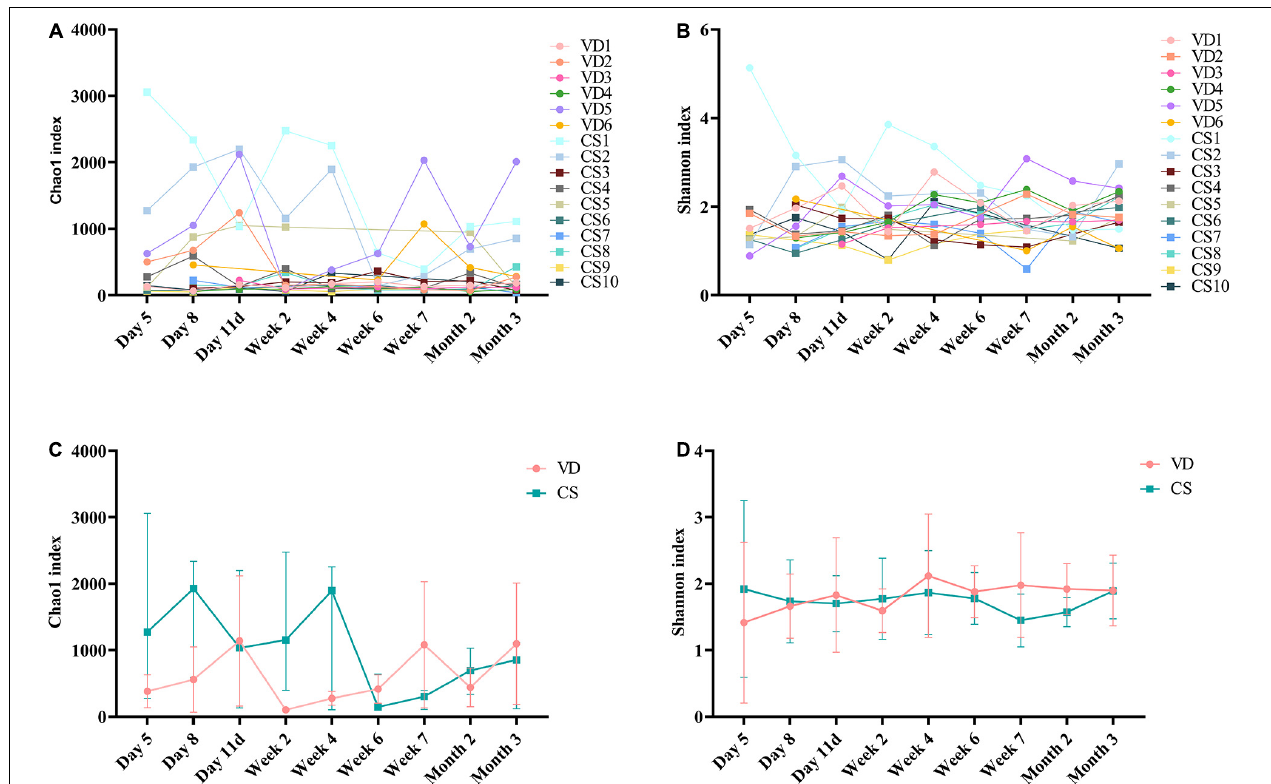
FIGURE 2 | Alpha diversity dynamic of the gut microbiota based on 9 time points between infants born with vaginal delivery and born with cesarean section. (A) Chao1 index; (B) Shannon index; (C) the comparison of Chao1 index between VD and CS at 9 time points (Mann–Whitney U test, all p > 0.05); (D) the comparison of Shannon index between VD and CS at 9 time points (Mann–Whitney U test, all p > 0.05). The results were reported as median values (minimum–maximum). VD, vaginal delivery; CS, cesarean